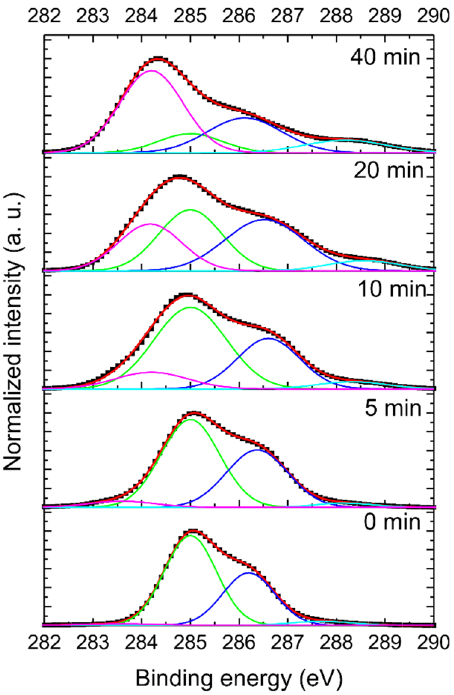
Figure 3. C 1s spectra of the pristine H-DND sample (0 min) and laser-irradiated H-DNDs samples. The irradiation time (5, 10, 20, and 40 min) is indicated. Experimental data points are shown as black squares, overall spectra fits as red lines, and the particular bond components as green (sp 3 ), magenta (sp 2 ), blue (C–N, C def ), and cyan (C=O).